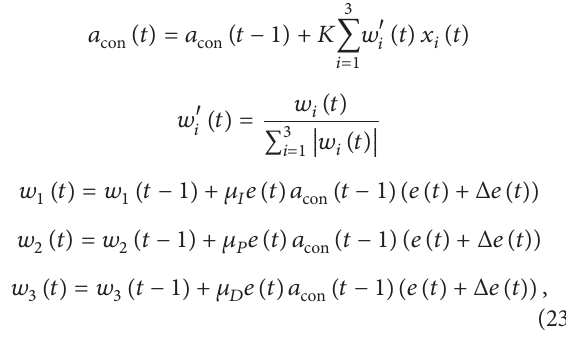
according to Table 1. The longitudinal velocity, acceleration, and location information of the vehicle model are transmitted from CarSim to